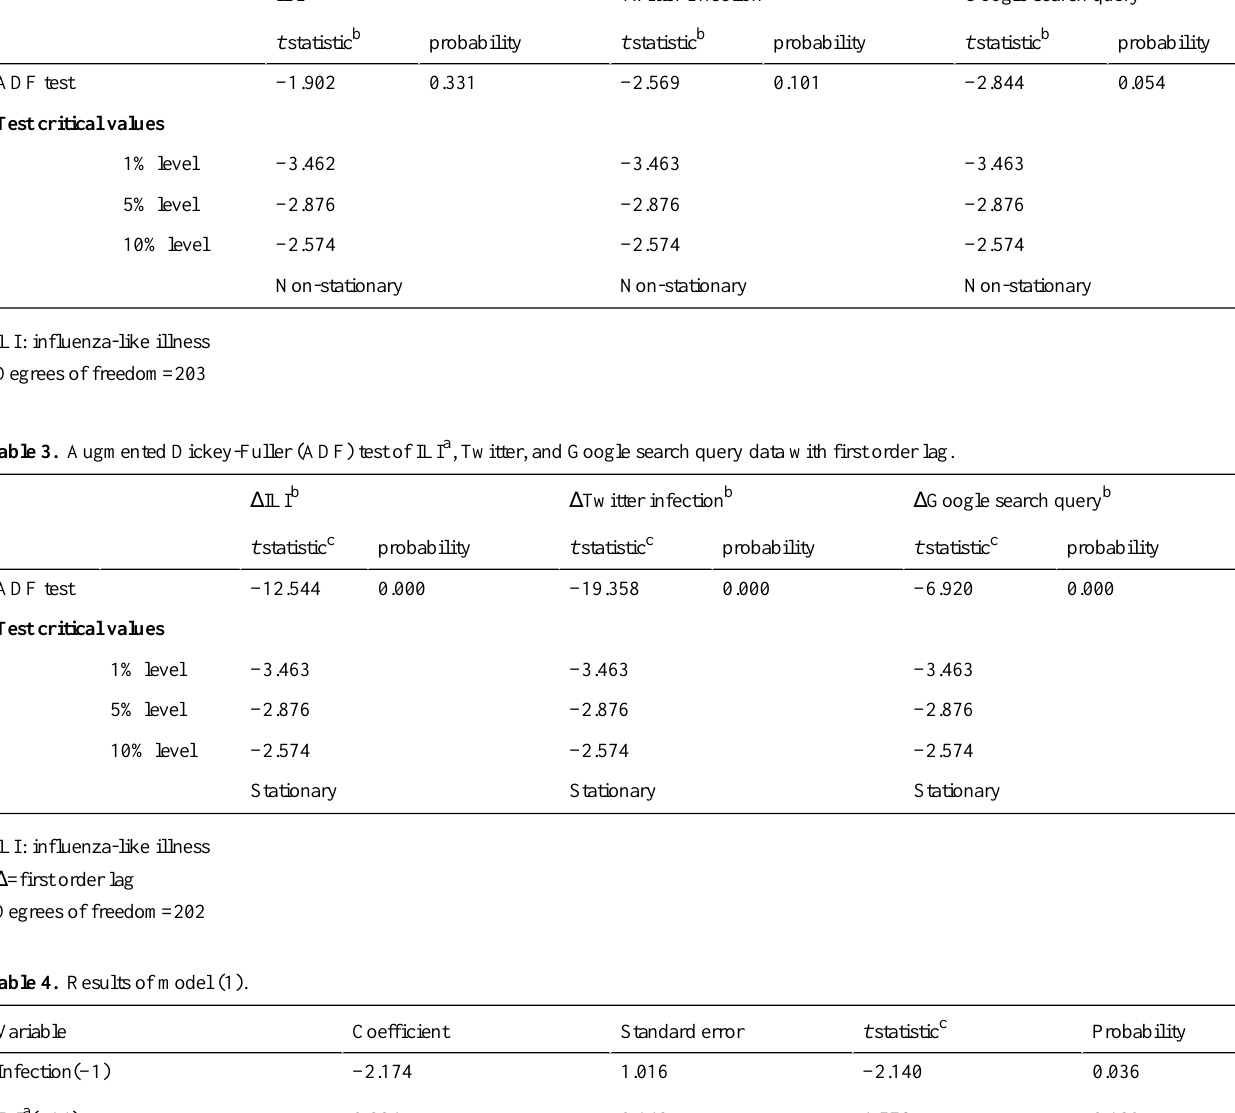
Google search queryTwitter infectionILI